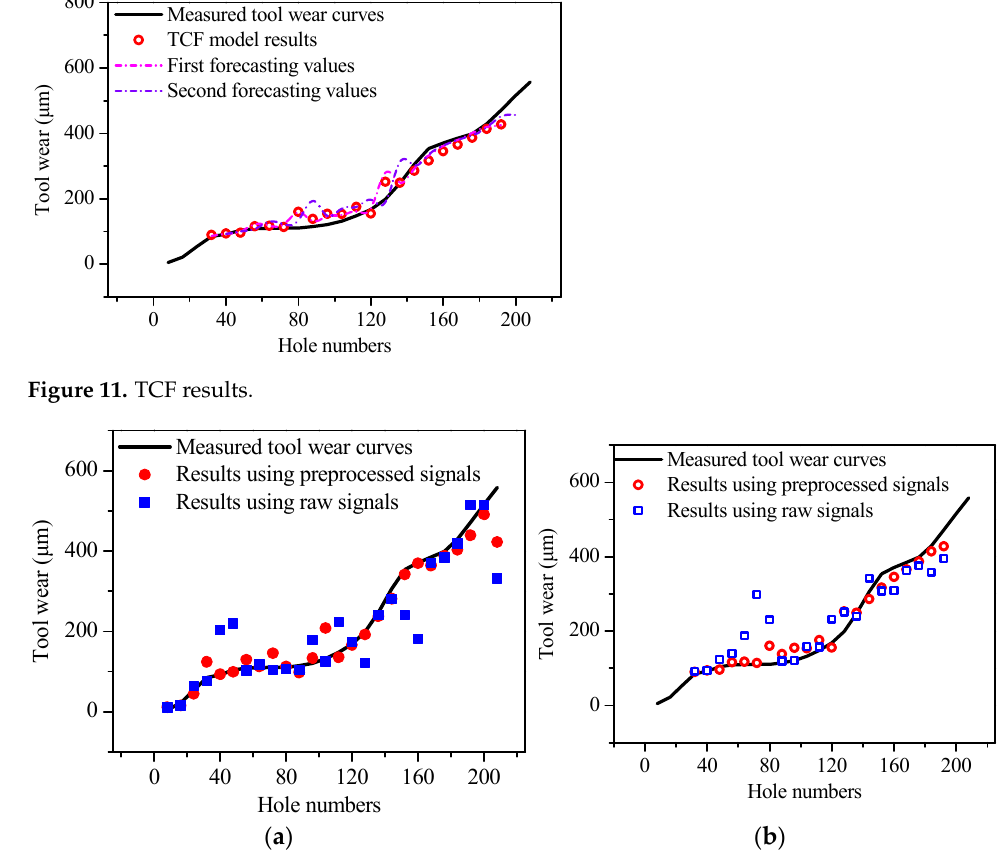
Figure 12. Comparison between models with data preprocessing and without preprocessing: ( a ) TCM results; ( b ) TCF results.